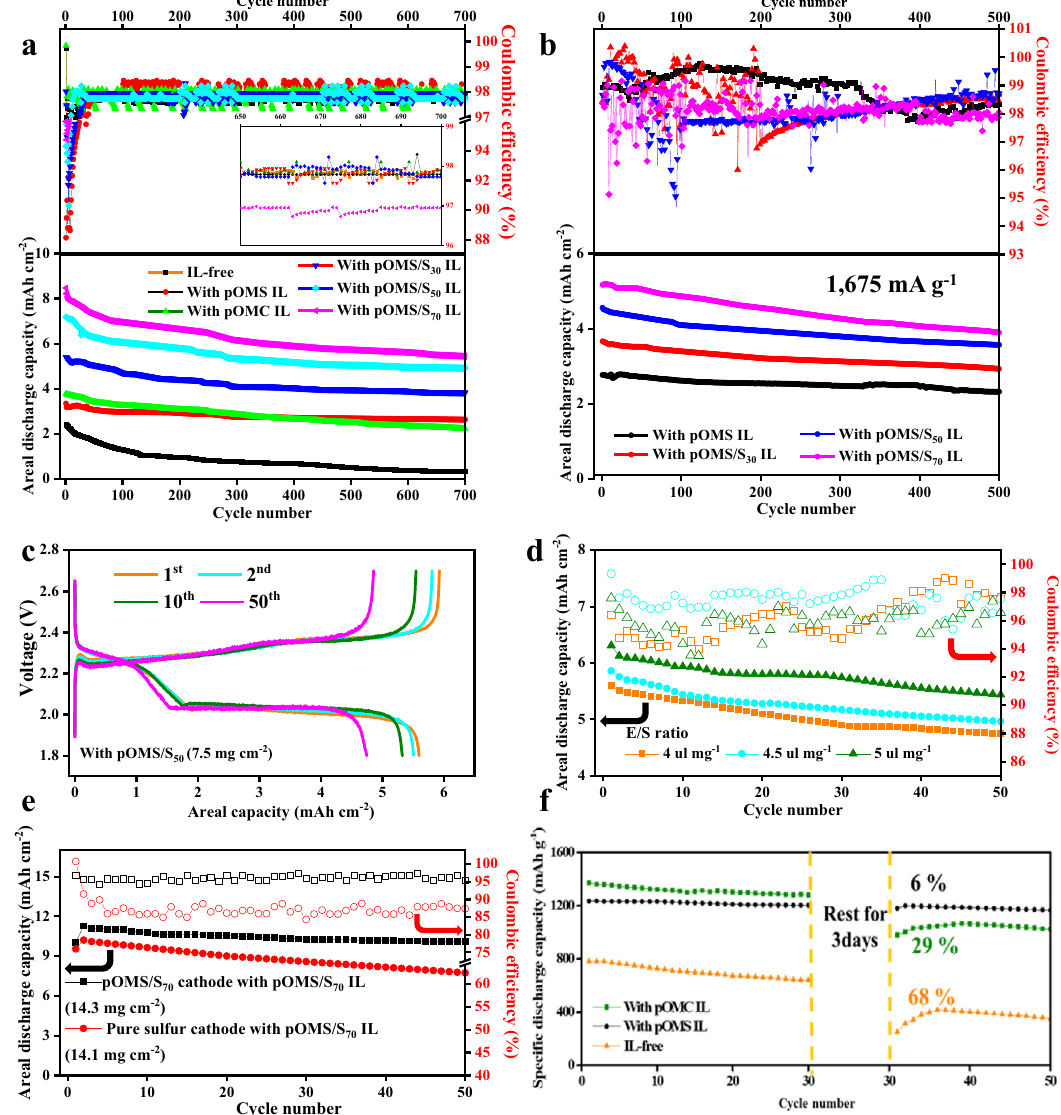
Fig. 4 Electrochemical energy storage performance of Li-S cells with and without interlayers. a Cycling performances of IL-free and different IL cells at a charge/discharge speci fi c current of 335 mA g − 1 for 700 cycles at 25 °C. b High speci fi c current cycle performance with pOMS IL and pOMS/S x ILs at 1675 mA g − 1 for 500 cycles at 25 °C. The top and bottom panels in a and b represent the Coulombic ef fi ciency and areal discharge capacity verse cycle number, respectively. c Galvanostatic charge-discharge pro fi les under E/S ratio of 4 µ l mg − 1 at 25 °C. d Cycle performances of pure sulfur cathode with pOMS/S 50 IL under different E/S ratios at 167.5 mA g − 1 for 50 cycles at 25 °C. Hollow and solid symbols represent coulombic ef fi ciency and areal discharge capacity, respectively. e Cycling performance of pure sulfur cathode (The pure sulfur cathode was composed of sublimed sulfur 70 wt. %, binder 10 wt. %, and electron-conducting agent 20 wt. %) with pOMS/S 70 IL (total sulfur loading of 14.1 mg cm − 2 , see Supplementary Information Table 6) and pOMS/S 70 cathode with pOMS/S 70 IL (total sulfur loading of 14.3 mg cm − 2 ) under E/S ratio of 5 µ l mg − 1 at 167.5 mA g − 1 for 50 cycles. f Self-discharge behaviour of different cells at 502.5 mA g − 1 at 25 °C after rest time of 3 days at room temperature. Total sulfur content includes both the cathode and the